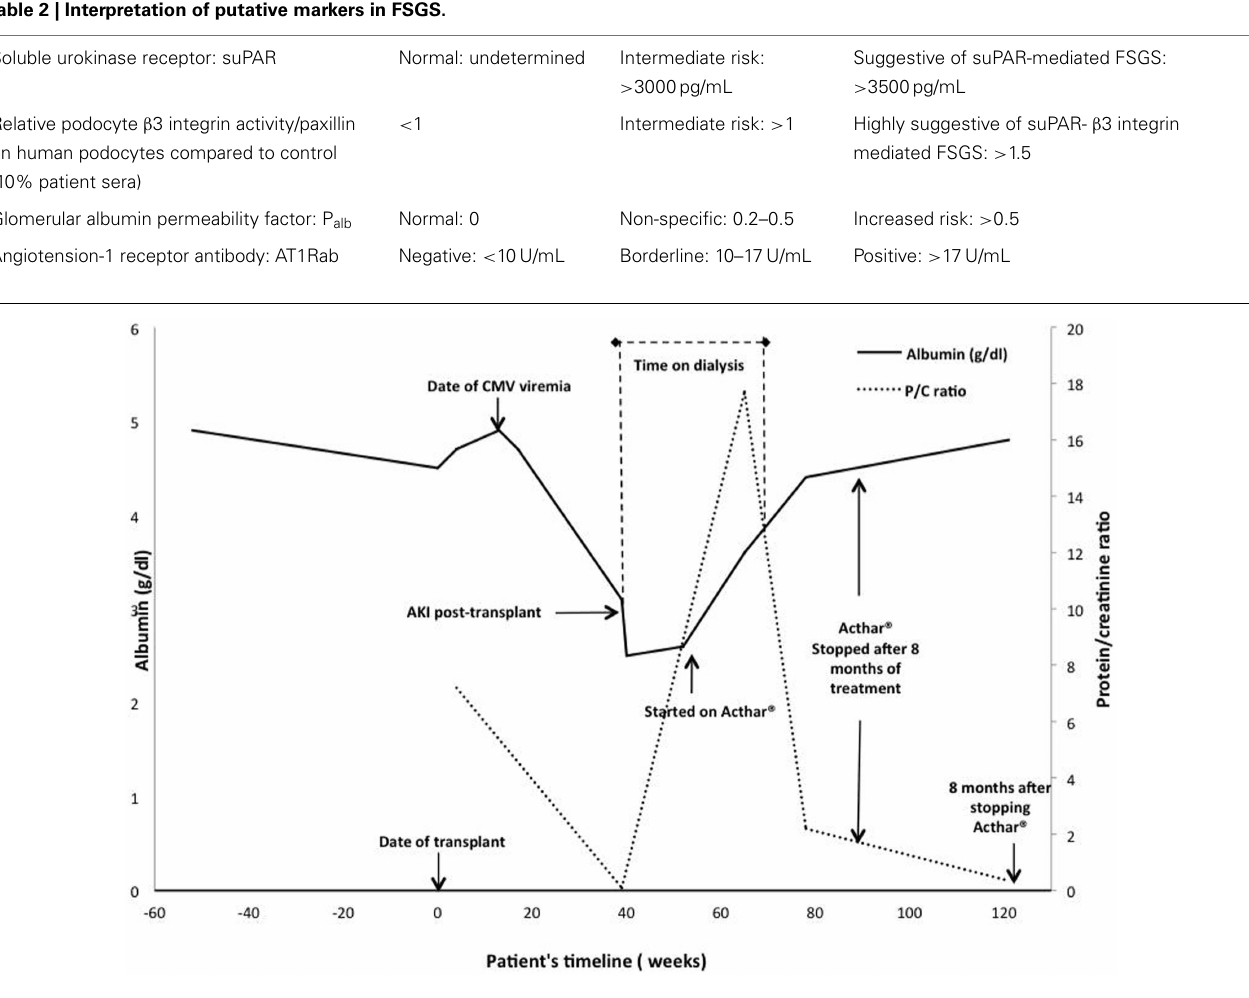
FIGURE 2 |Time course of events, treatments,and responses in serum albumin and urine protein excretion .The serum albumin level over time is depicted by the solid black line and the urine protein/creatinine ratio by the dashed gray line.The value at 40weeks was imputed to be 0 because the patient was